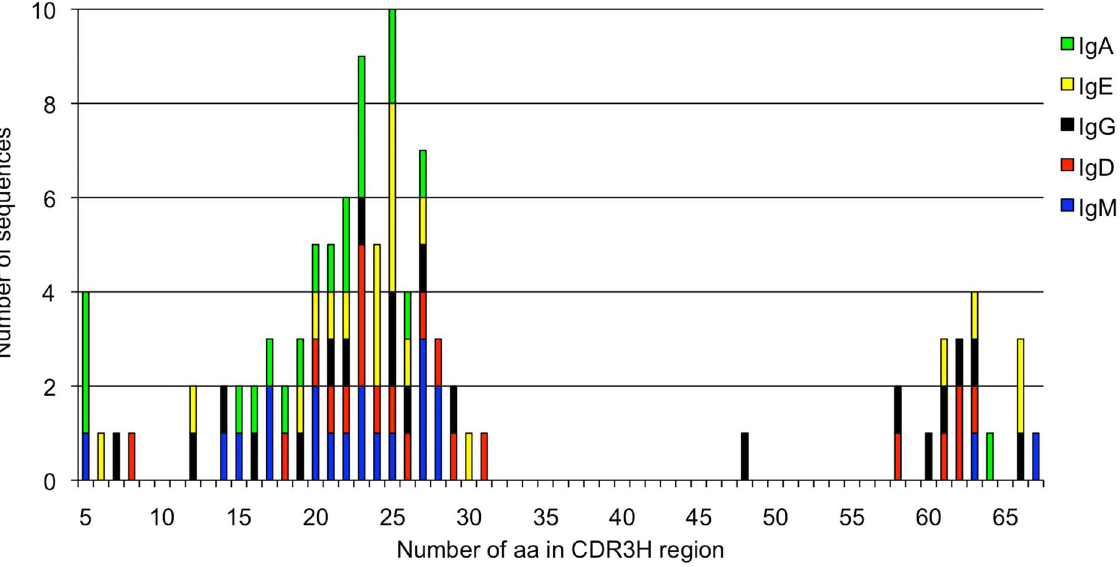
Figure 4. Three distinct sizes of CDR3H in all isotypes. The lengths of CDR3H of all sequences analyzed was divided into three groups. These groups were identified in each isotype, marked in different colors. The numbers of amino acid residues (aa) in CDR3H are indicated on the horizontal axis, whereas the number of sequences possessing each number of aa is provided on the vertical axis. doi:10.1371/journal.pone.0064234.g004 PLOS ONE |